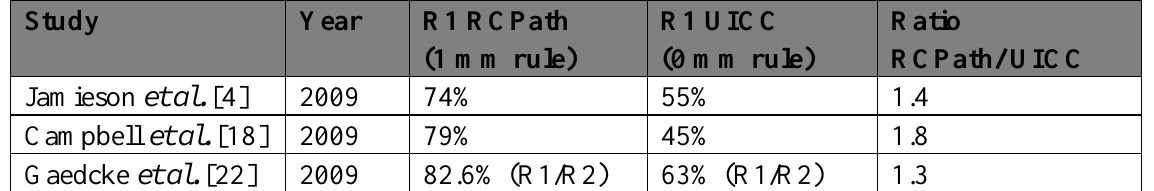
Table 3 . Comparison of R1 rates for PDAC between application of the UICC and RCPath criteria.